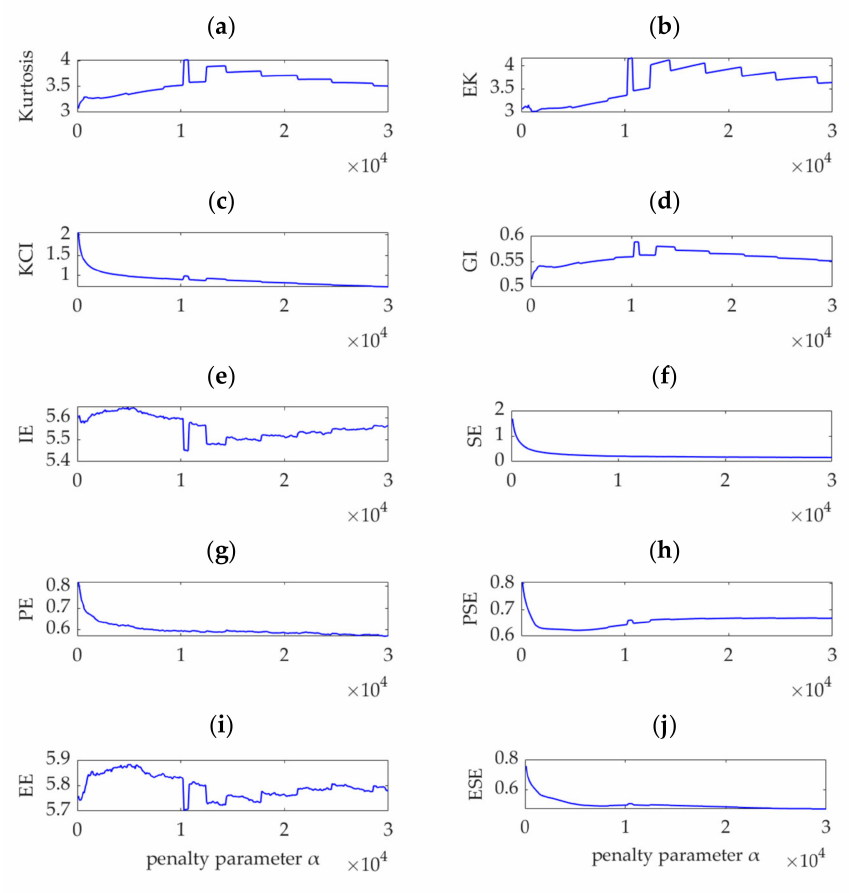
Figure 18. Relationship between different indices and the penalty parameter, α